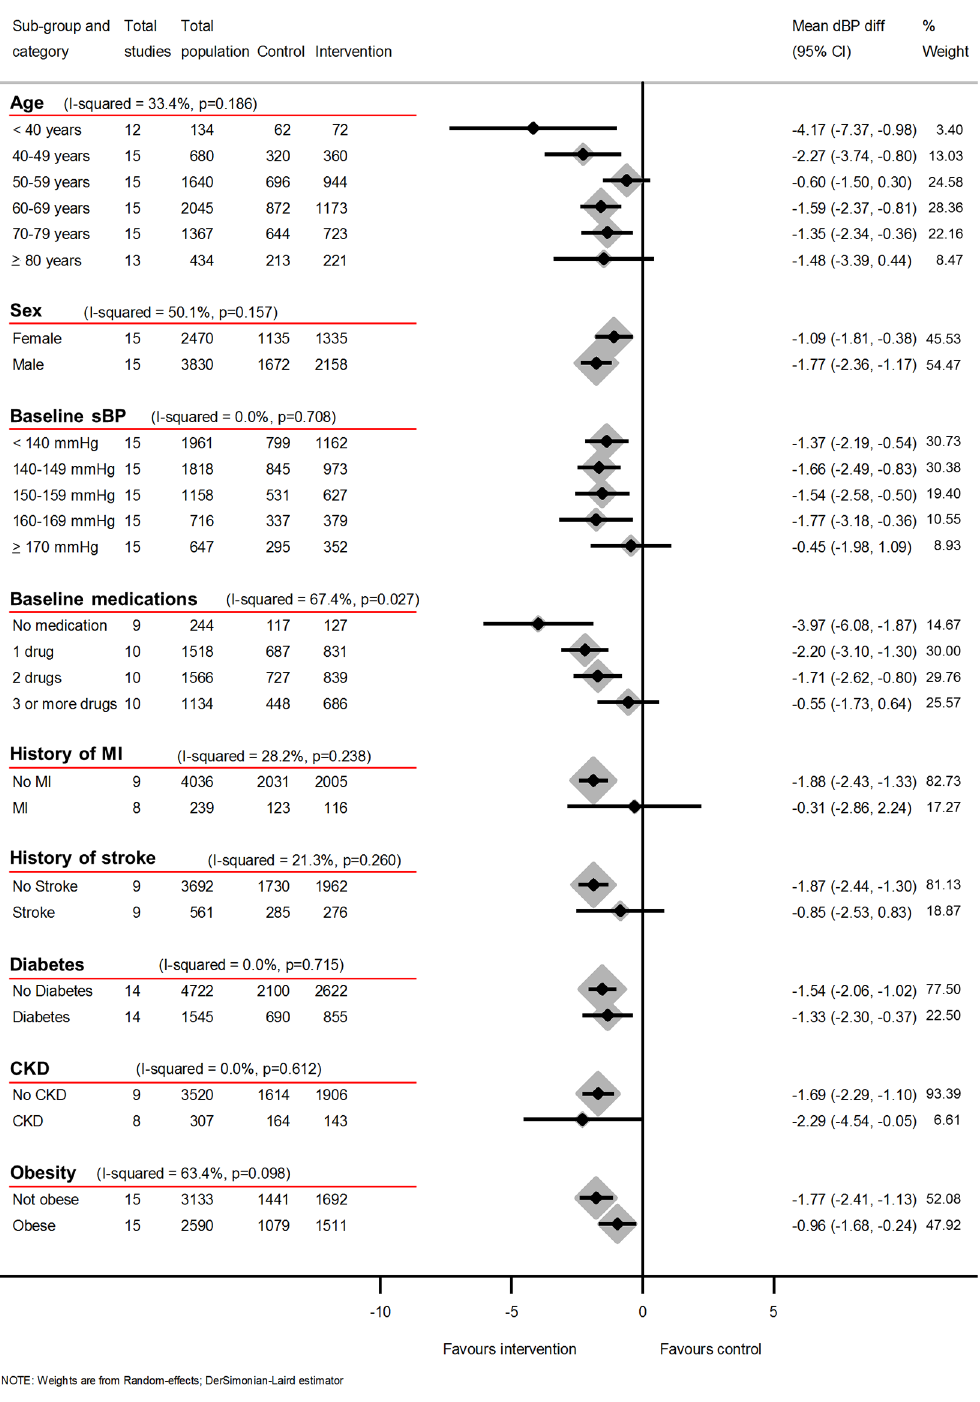
Fig 7. Impact of self-monitoring of BP on clinic dBP at 12 months according to prespecified subgroups (15 studies). Obesity definedas BMI (cid:21) 30 kg/m 2 . Changein dBP at 12 months adjustedfor age, sex, baselineclinic BP, level of intervention, and studies contributing patient data. Abbreviations: BMI, body mass index; BP, blood pressure; CKD, chronic kidney disease;dBP, diastolicblood pressure; MI, myocardial infarction.